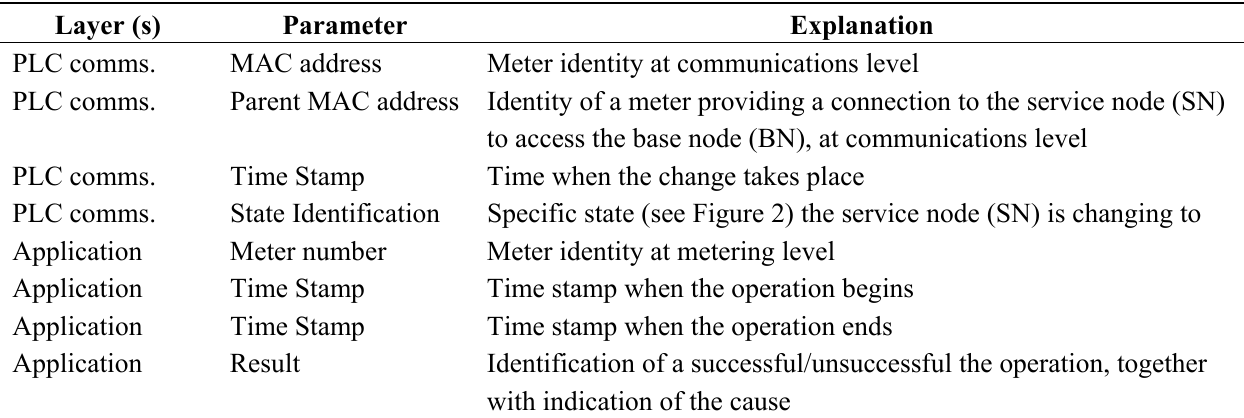
Table 1. Application layer required parameters for performance